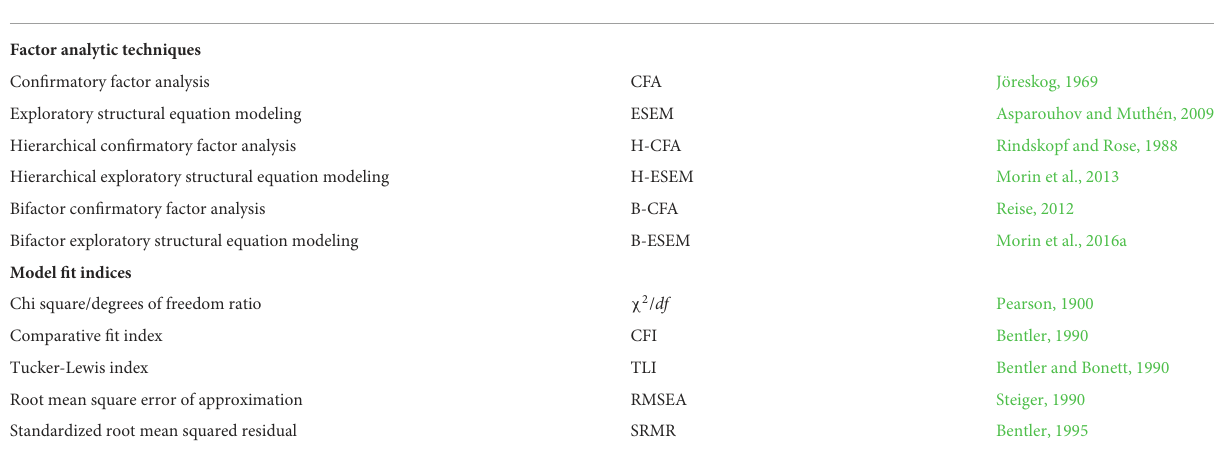
TABLE 1 Factor analytic techniques and model fit